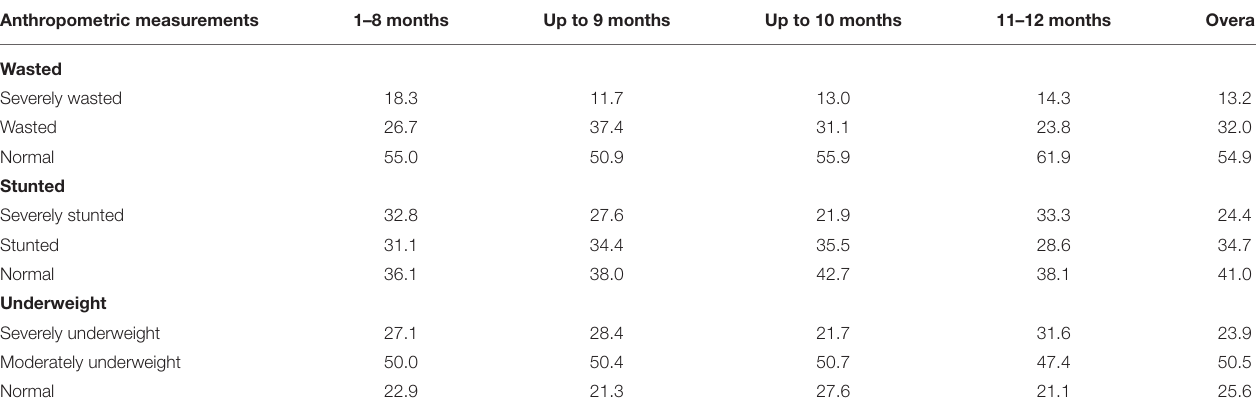
TABLE 8 | Nutritional status across duration of the consumption of chikkis and granules. Anthropometric